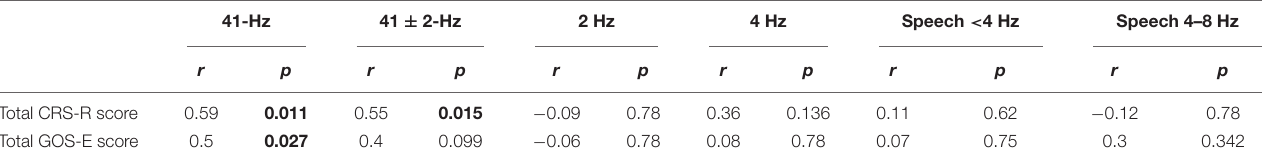
FIGURE 6 | Correlations between the phase coherence for the speech tracking response in delta and theta bands and clinical evaluations. (A–D) Correlations between the phase coherence for the speech tracking response in delta, theta bands, and CRS-R, GOS-E score showed no statistical significance. TABLE 1 | Correlations between CRS-R total score, GOS-E total score, and cerebro-acoustic phase coherence (FDR corrected). Significant P -values ( < 0.05) are shown in bold. 41-Hz 41 ± 2-Hz 2 Hz 4 Hz Speech < 4 Hz Speech 4–8